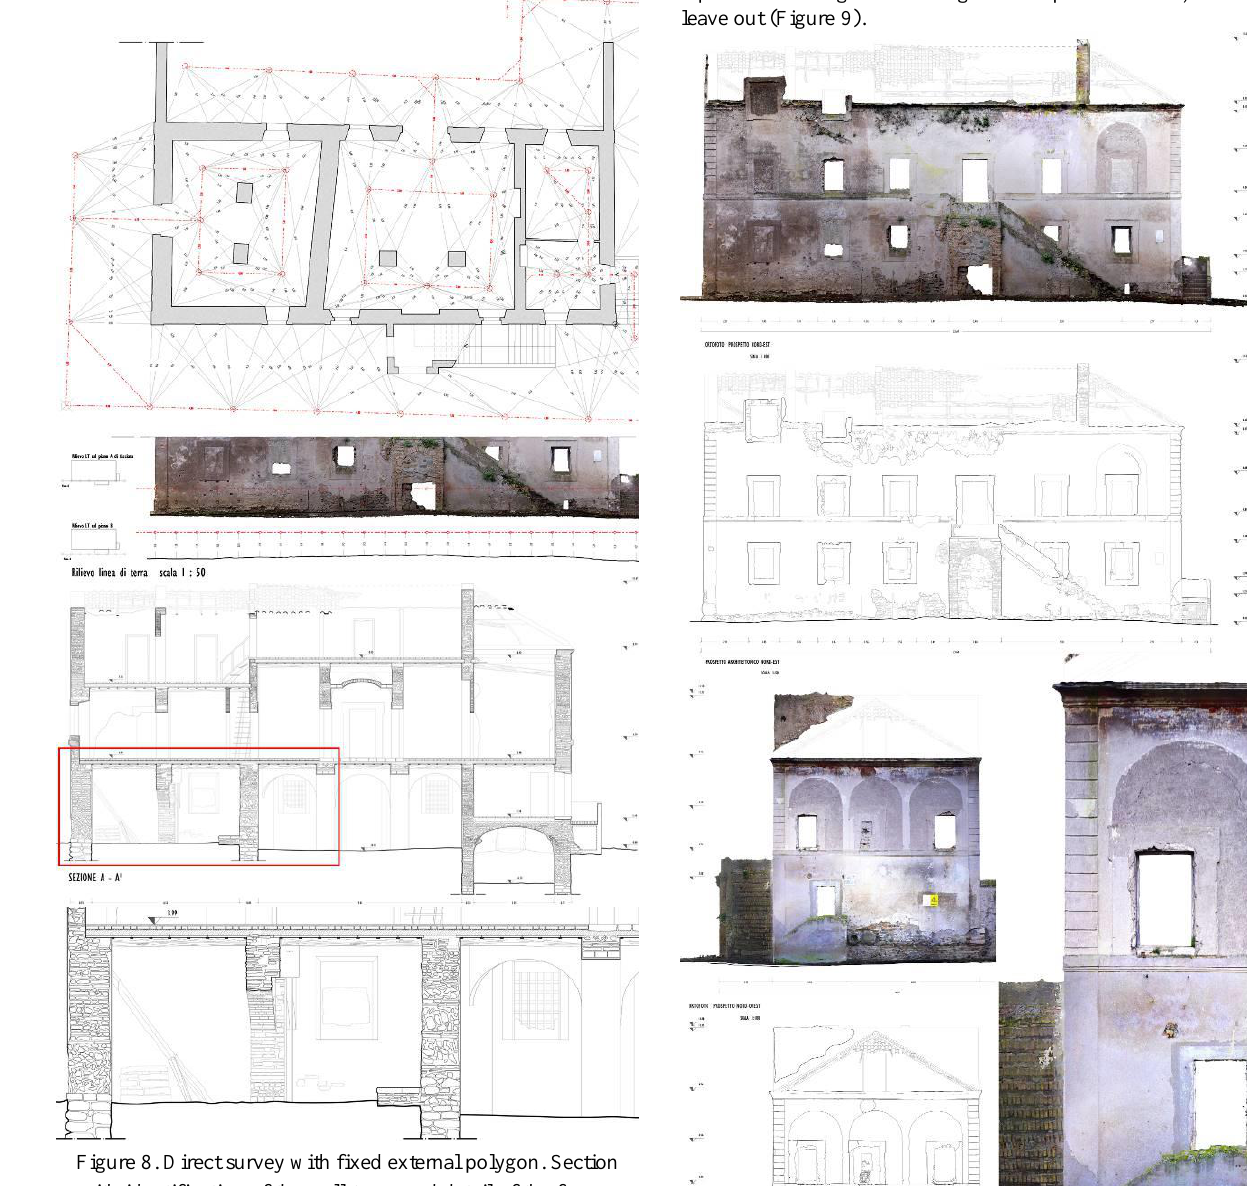
Figure 8. Direct survey with fixed external polygon. Section with identification of the wall types and detail of the former sheepfold on the ground floor with external access.